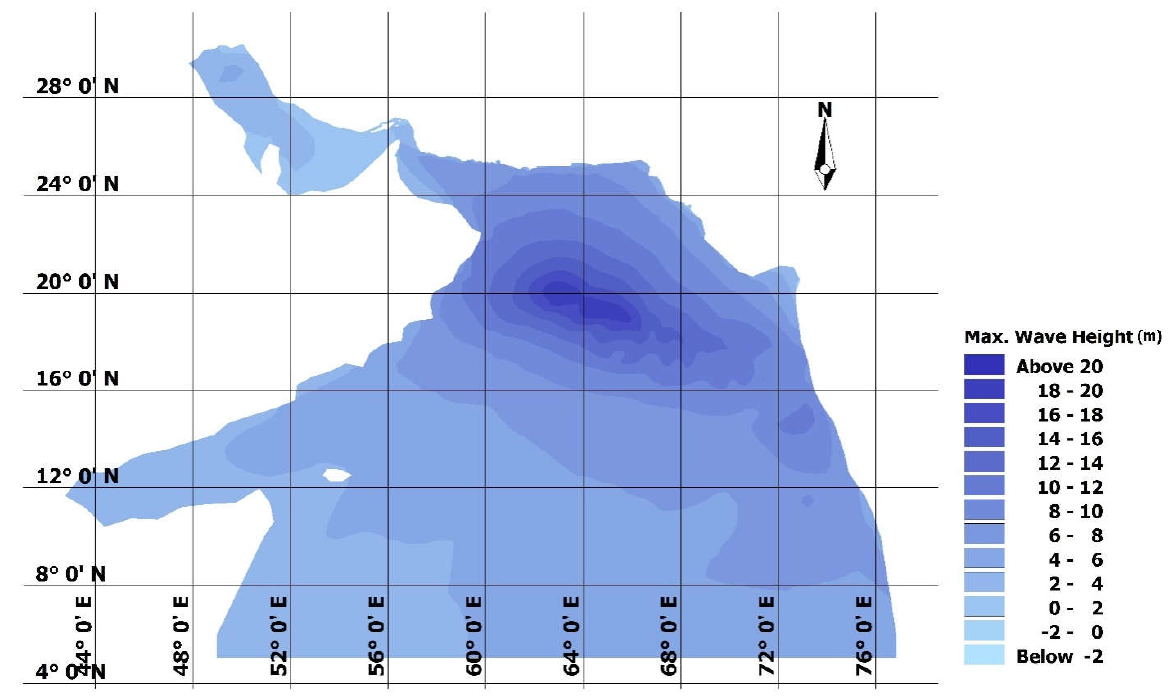
Figure 13. Maximum wave height in the study area during tropical cyclone Kyarr.